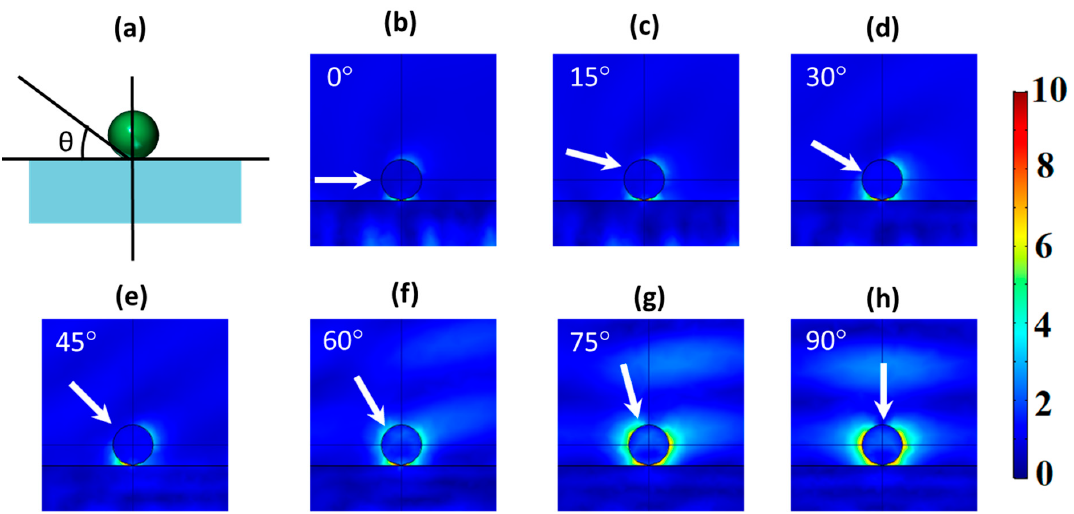
Figure 5. ( a ) Scheme of the geometrical conditions of the considered system. ( b )–( f ) FEM simulations of the scattered field of a Cu 2 O spherical particle with a diameter of 184 nm on a silicon substrate for different angles of the incident beam with respect to the substrate. The incident wavelength was 632 nm. White arrows label the incident direction.